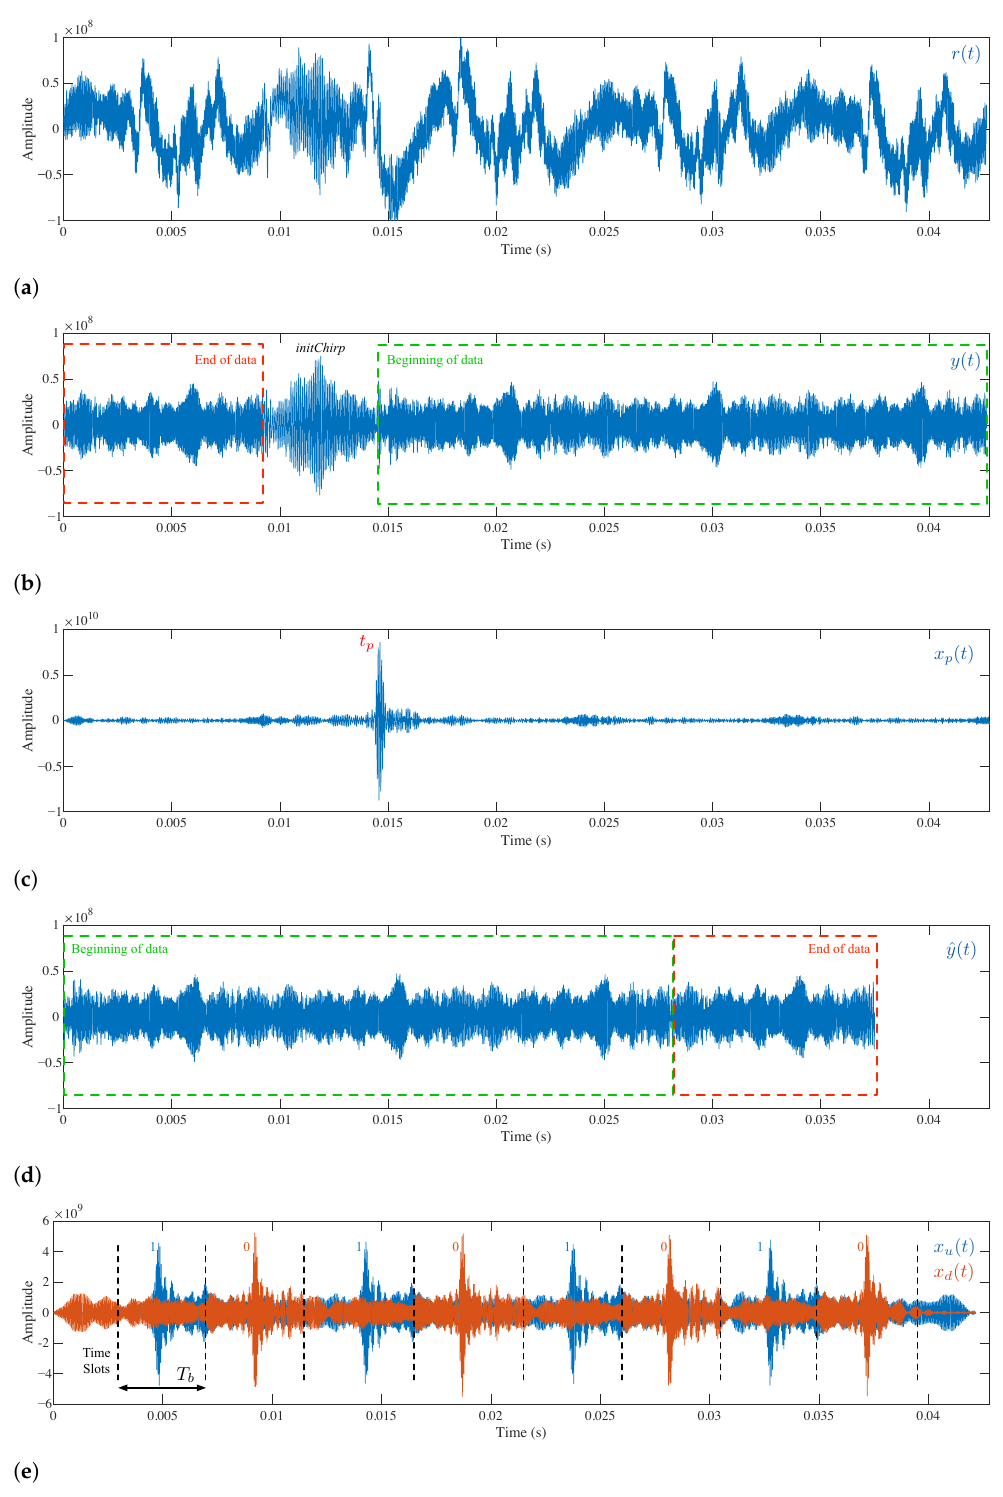
Figure 5. Receiver signal processing. ( a ) Raw received signal. ( b ) Pass band filtered received signal. ( c ) Correlation with initChirp. ( d ) Rearranged data signal. ( e ) Correlation with upChirp and